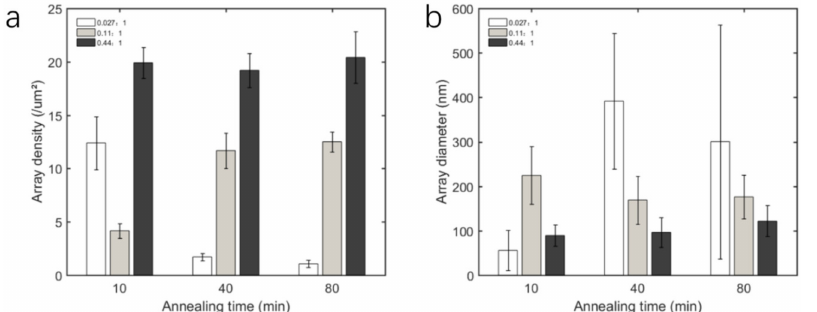
Figure 8. Variation of nanoarrays morphology parameters with ZnAC/PVA volume ratio α and annealing time. ( a , b ) are statistics of the number density and diameter of nanorods,